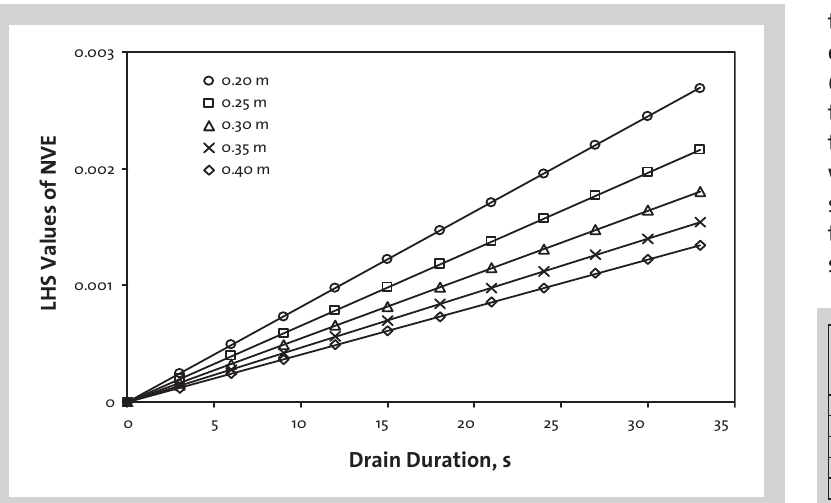
Figure 3 (left above): Drain amounts of 60 wt% sucrose aqueous solution against drain durations at 299.15 K, using a set of experimental data out of quintuple experimental data. Figure 4 (right above): Quintuple experimental data of drain amounts at various drain durations, applied to non-Newtonian viscosity equation (NNVE) for the calibration of the vis- cometer to determine behavior index n and consis- tency index k of 60 wt% sucrose aqueous solution at 299.15 K. Figure 5 (left below): Left-hand side (LHS) values of Newtonian viscosity equation (NVE) for various drain tubes and durations with 60 wt% sucrose aque- ous solution at 299.15 K. Table 1: Average left-hand side (LHS) values of non-New- tonian viscosity equation (NNVE), and their standard deviations and standard deviation percentages, using quintuple experimen- tal data of 60 wt% sucrose aqueous solution at 299.15